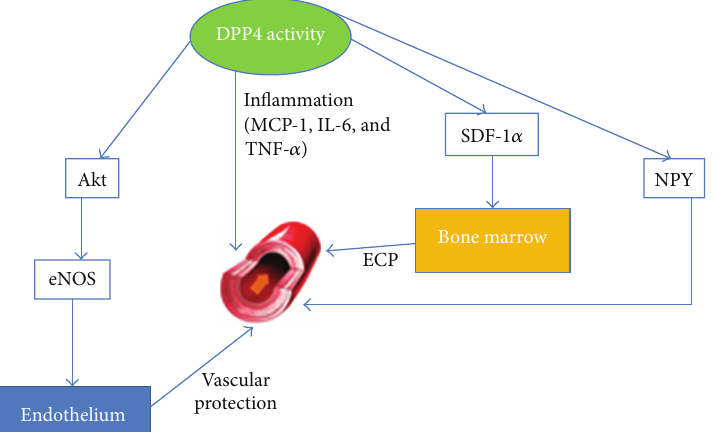
Figure 1: Effect of DPP4 on cardiovascular